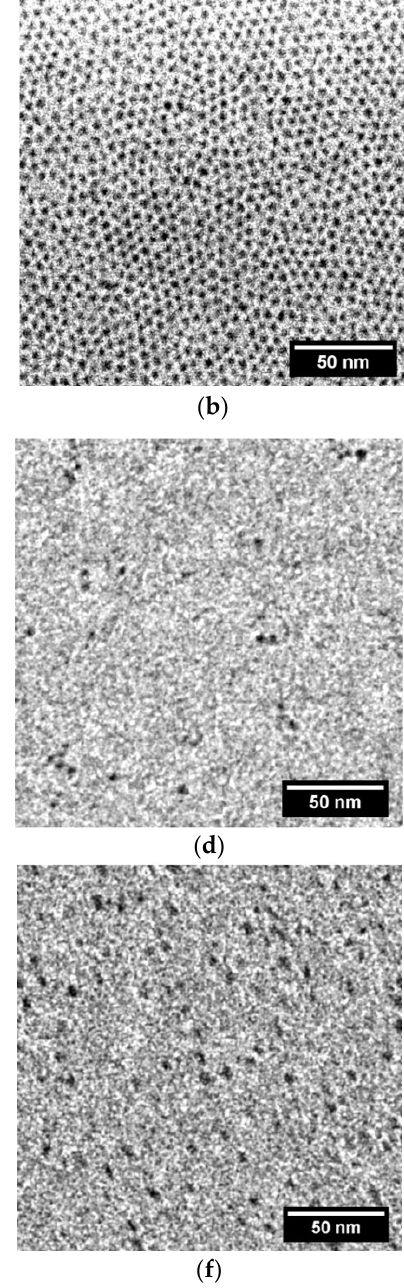
Figure 6. TEM microphotographs of dried sols of CdSe ( a ) and CdSe/ZnS QDs ( b ) and monochelic PMMA M1 and telechelic PMMA T1 and QDs at Z = 0.1: M1 —CdSe ( c ), M1 —CdSe/ZnS ( d ), T1 —CdSe ( e ), T1 —CdSe/ZnS ( f ).